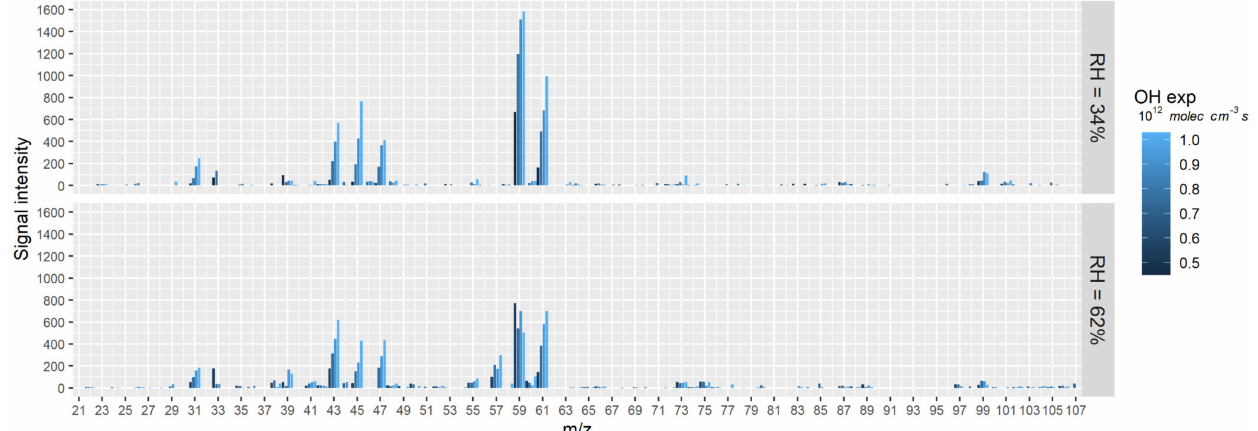
Figure 6. Mass spectrum of gas phase products observed in experiments using (NH 4 ) 2 SO 4 seed particles. All the spectrums shown are background (OH exposure = 0)